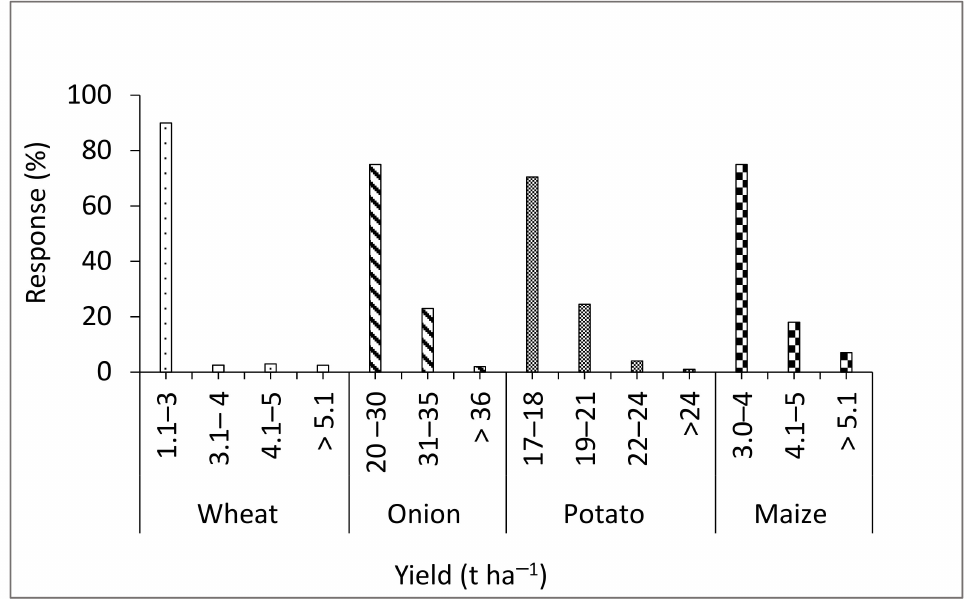
Figure 5. Major irrigated crops in Koga irrigation